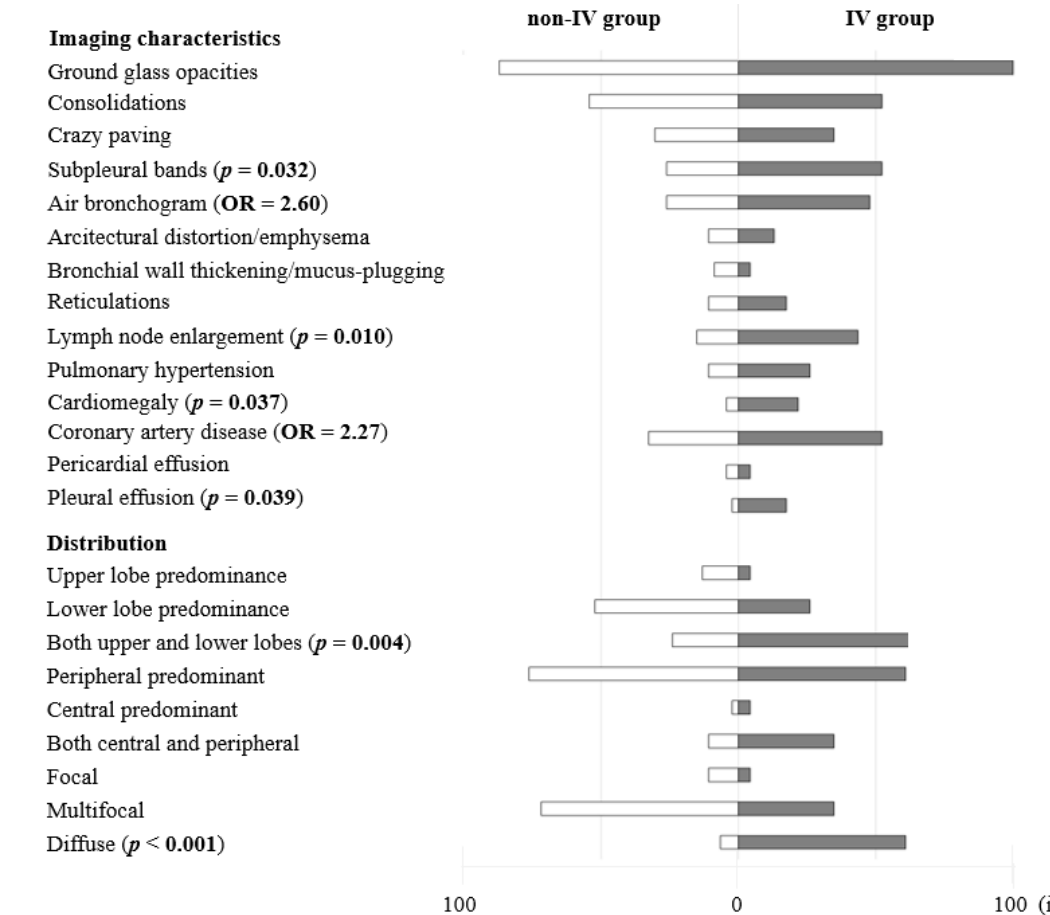
Figure 2. Overview of CT imaging characteristics. Prevalence of imaging characteristics in the invasive ventilation (IV) and non-IV-group in %, corresponding p -values ( p ) and odds ratios (OR).